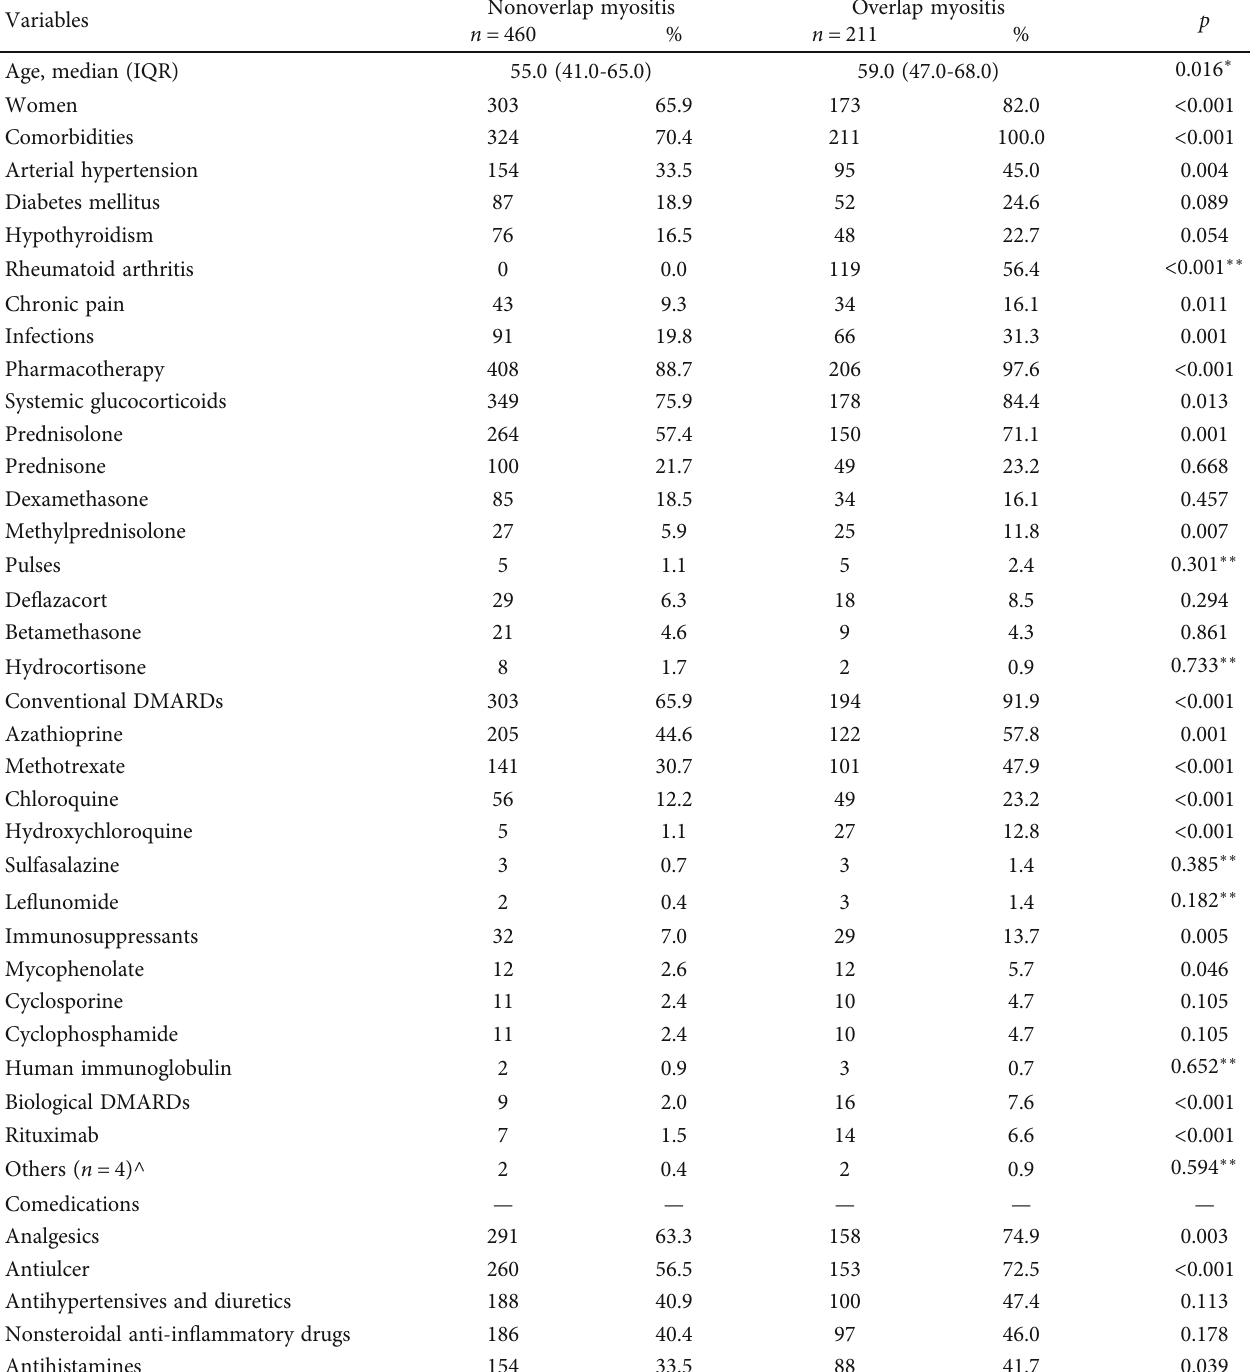
Table 1: Comparison of some sociodemographic and pharmacological variables between the types of overlap myositis and nonoverlap myositis in